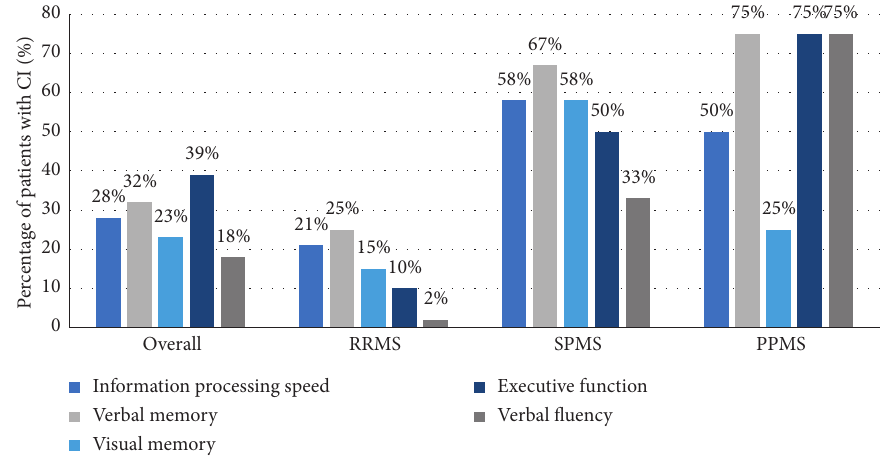
Figure 1: Cognitive impairment in patients with multiple sclerosis. Table 3: Characteristics of cognitively impaired and cognitively intact MS patients.